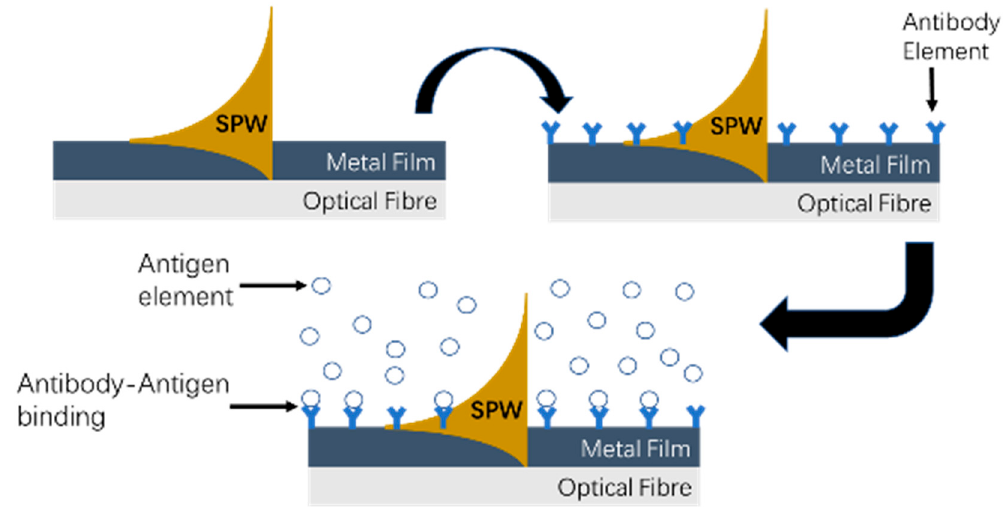
Figure 8. The detection mechanism based on FOPS for antibody ‒ antigen binding process [92].